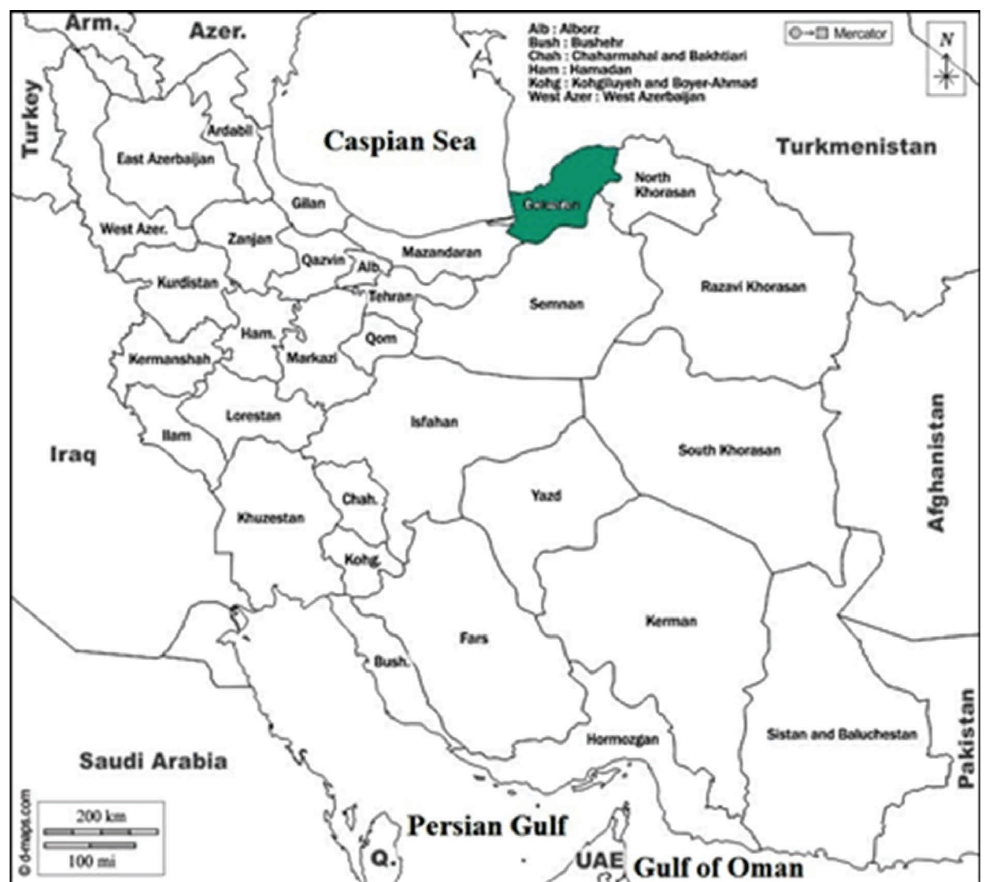
Figure 1: Te map of Golestan Province, northeastern